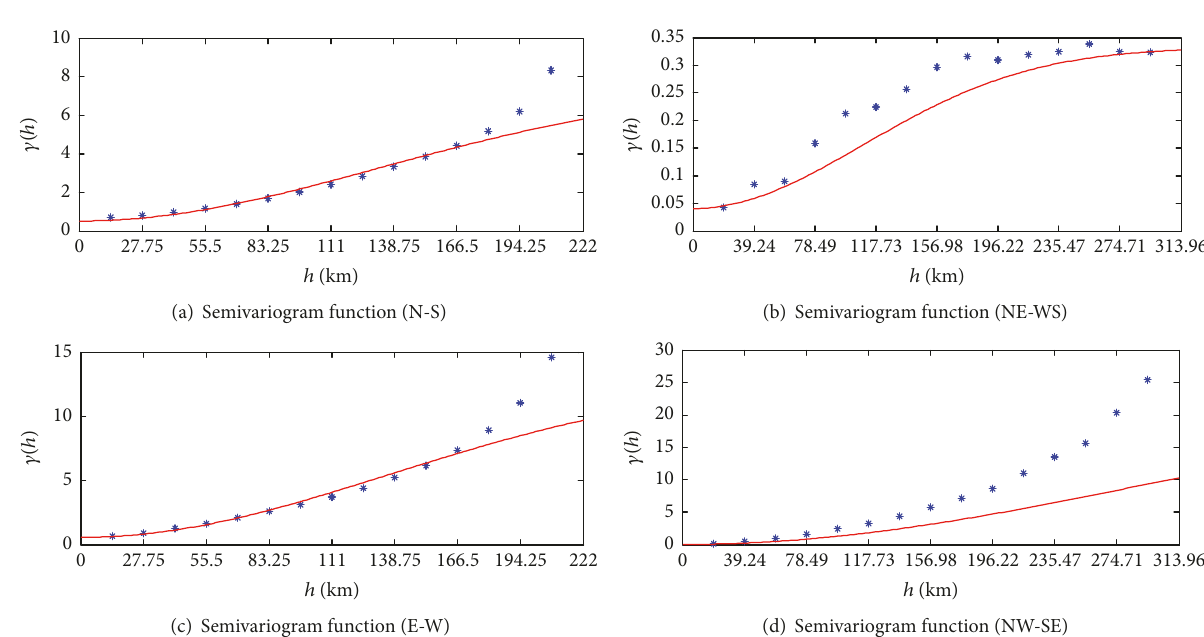
Figure 3: Four directions’ semivariogram functions of Figure 2(b)